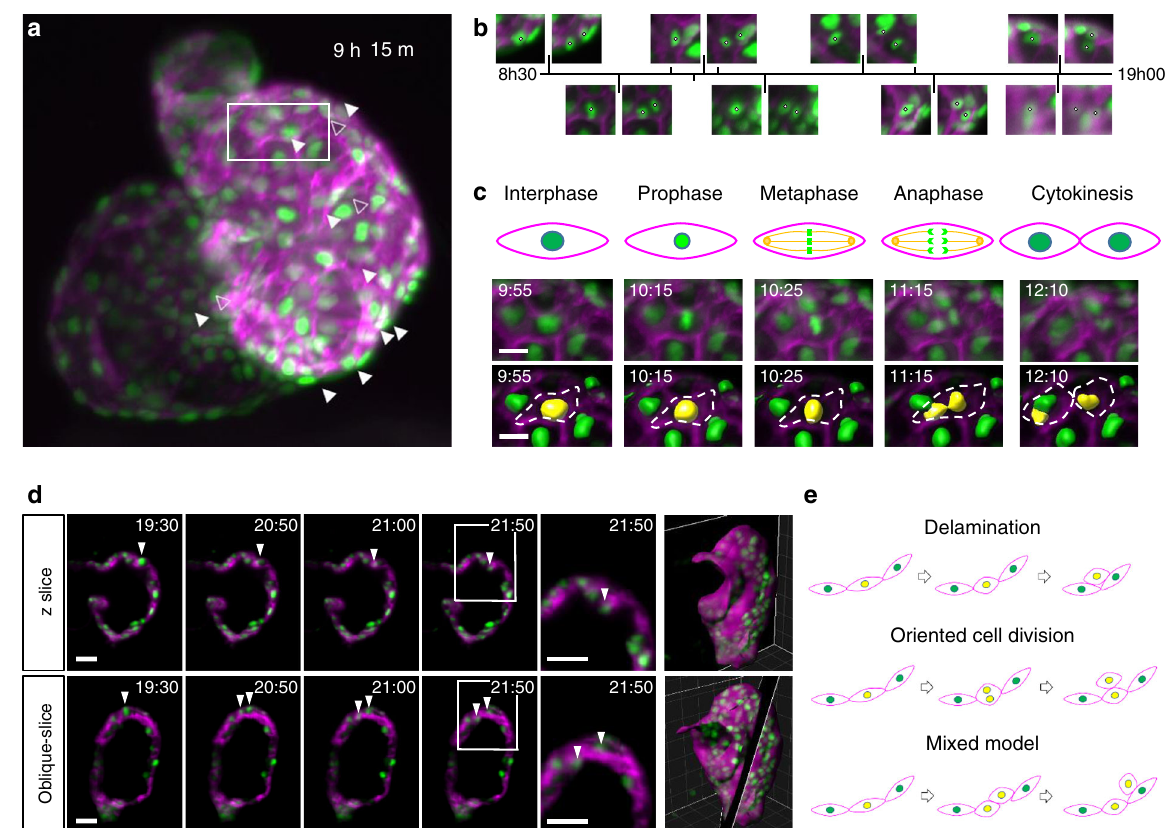
Fig. 6 Mapping cardiomyocyte migration and cell division during myocardial trabeculation. a Representative MIP from a 24 h time-lapse of a 72 – 96 hpf zebra fi sh (Supplementary Video 10). Image shows cardiomyocyte nuclei (green — transgene myl7:h2b-gfp ) and cardiomyocyte cell membranes (magenta — transgene myl7:mKate-CAAX ), with strongest signal expressed in the ventricle. Nuclei of cardiomyocytes which will later divide are indicated by white arrowheads (open-arrowheads for less-obvious divisions near the posterior wall of the heart). Region-of interest for c is indicated with white box. b Detail from time-lapse: pairs of images plotted on a timeline, illustrating selected cardiomyocytes shortly before (left) and after (right) cell division; nuclei indicated with white circles. c A selected cardiomyocyte division clearly exhibits key stages of mitosis. Mitotic stages (schematic: top row) are visible at selected timepoints from the time-lapse sequence (MIPs: middle row), and the nuclear volume changes and karyokinesis typical of cell division can be seen (dividing nucleus surface-rendered in yellow: bottom row). d A dividing cardiomyocyte nucleus is shown in the acquisition plane ( z -slice, top row) and in the plane of division (oblique slice, bottom row) across two and a half hours of imaging with 5 min time-lapse resolution. White arrowheads highlight the observation of two daughter cardiomyocyte nuclei in the oblique-slice, which would have been missed in the z -slice or 2D imaging. The fi nal time point is shown zoomed-in to highlight the migration of the two daughter cells across the time period. Whole rendered heart ventricle (magenta) with rendered nuclei (green) indicate the z -slice and oblique-slice views used. e Schematic illustrating three models of cardiac trabecular initiation: delamination model (top), cell division model (middle) and mixed model (bottom). Delaminating cardiomyocytes are indicated by a yellow nucleus. Scale bars: 30 μ m (10 μ m for